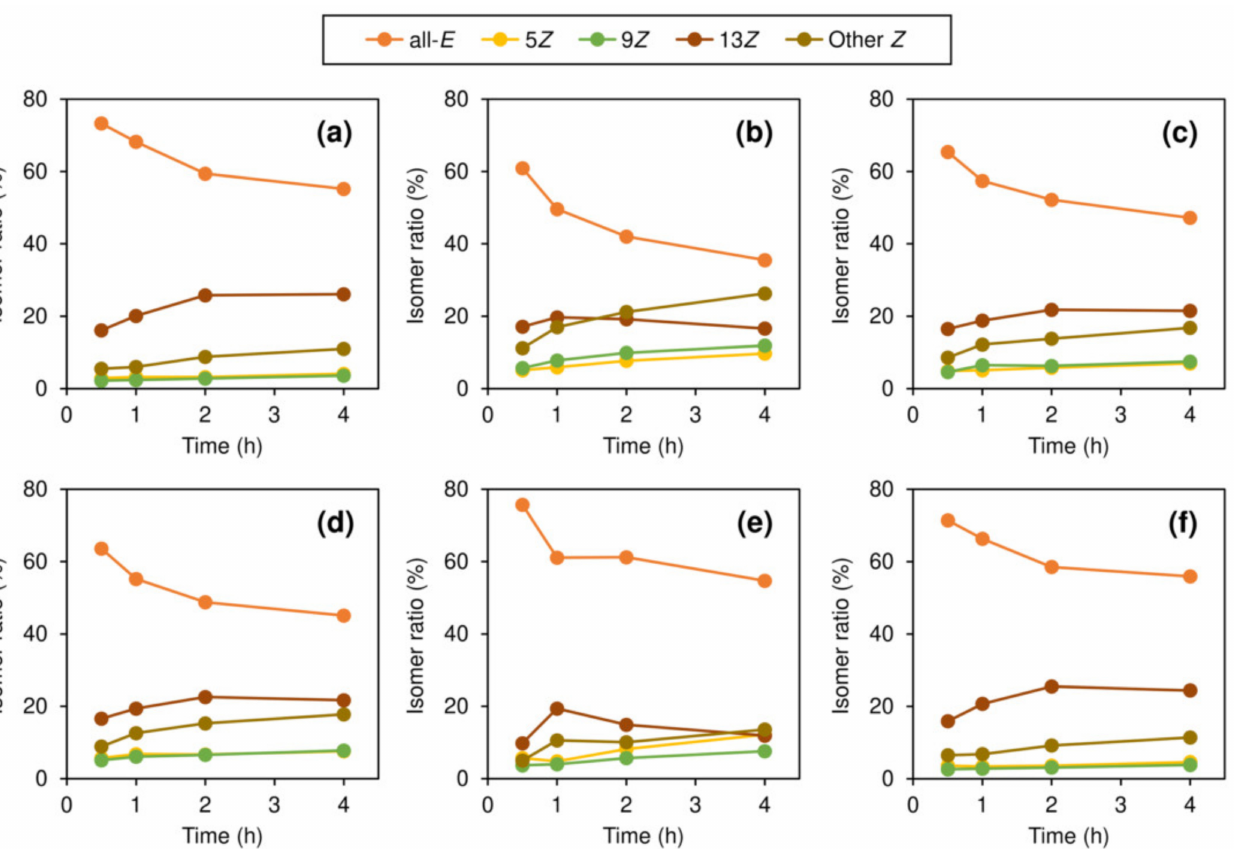
Figure 7. Effects of extraction time and foodstuffs on each lycopene ratio in the extract. The extraction was conducted ( a ) without foodstuffs and with ( b ) onion, ( c ) broccoli, ( d ) mustard, ( e ) makonbu, or ( f ) shiitake mushroom. The extraction was performed using ethyl acetate at 60 ◦ C. Error bars represent mean ± standard deviation ( n =